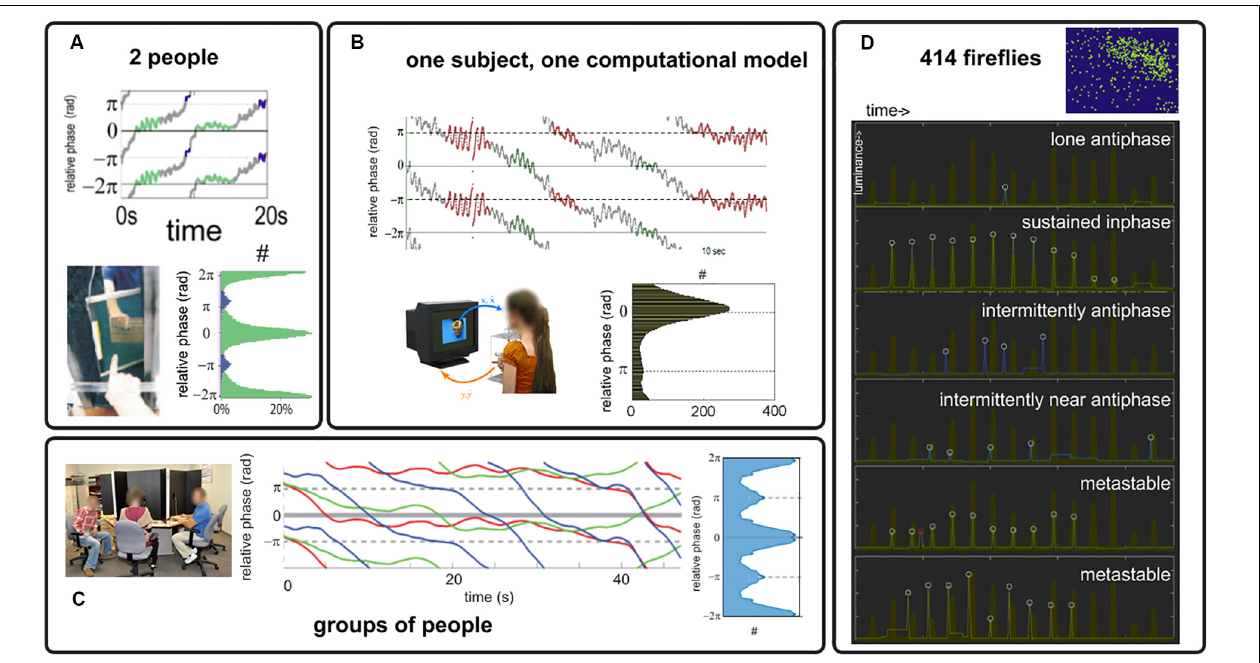
FIGURE 3 | Behavioral coordination in human dyads (A) , human interaction with a Human Dynamic Clamp (B) , ensemble of people (C) and to hint at generality, in fireflies flashing [white circles, (D) the thick brown trace indicates the collective behavior of their large colony]. Relative phase trajectories from (A–C) are chosen to illustrate an alternation of dwells and escapes that is typical of metastability. Attracting tendencies are found toward inphase and antiphase [see histograms in (A–C) , with count identified with the symbol #, showing relative phase distribution for the most strongly coupled conditions in their respective paradigms, see original references for details and for examples of weaker